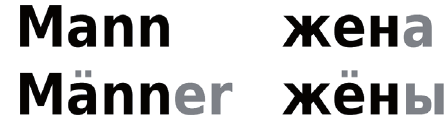
Fig. 1. Uniform stem with